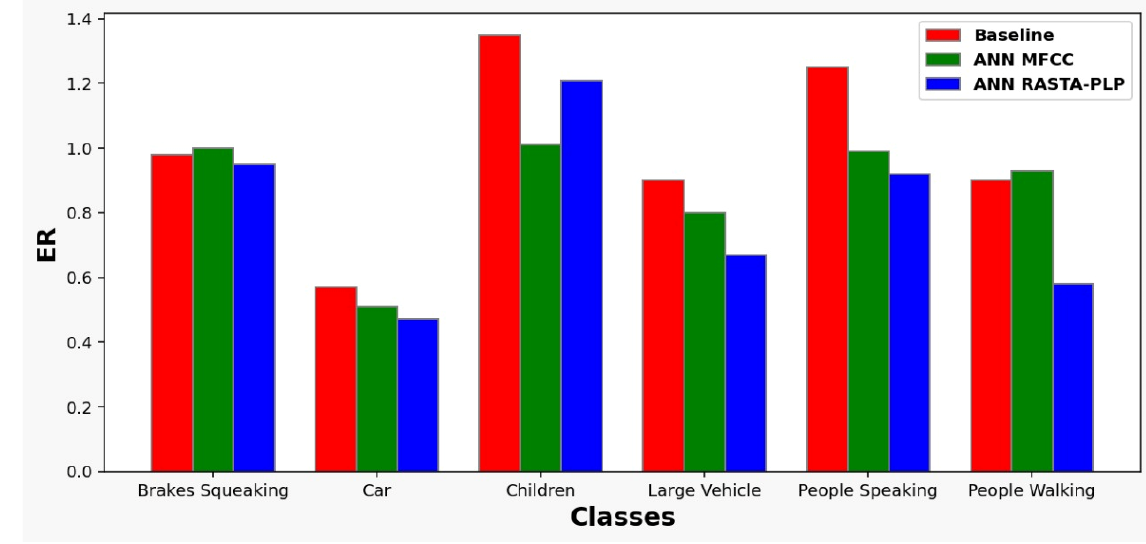
Figure 5. ER comparison using ANN classifier.